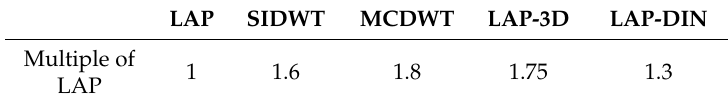
Table 4. Relative computational complexity of different video fusion methods.